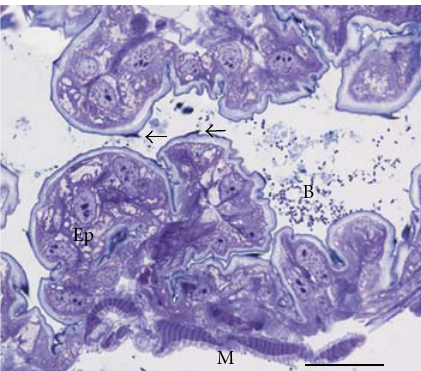
Figure 7: Posteriorly directed cuticular spines (arrows) subtended by a single cell layer of epithelium (Ep) and muscle (M). Bacteria (B) can be seen in the lumen of the pharynx. Scale bar = 30 μ m.